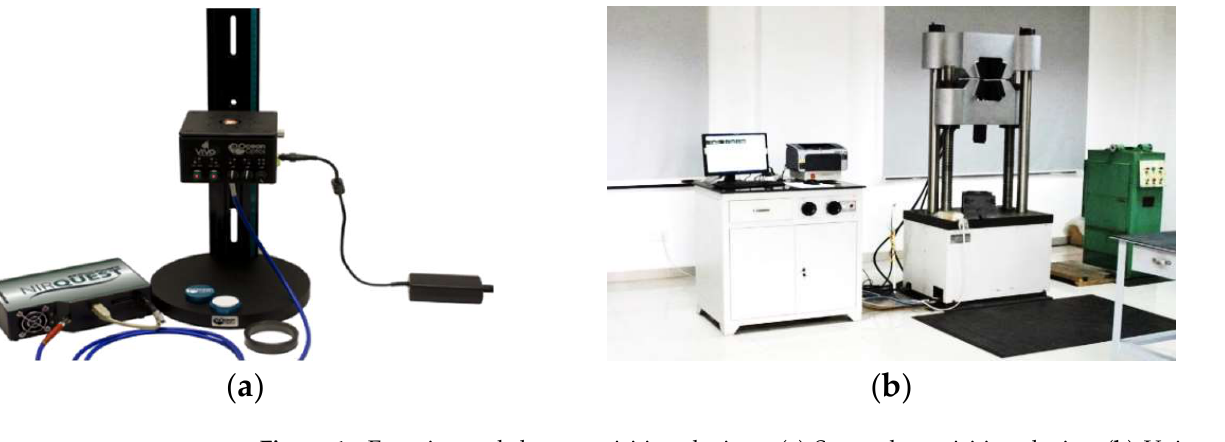
Figure 1. Experimental data acquisition devices: ( a ) Spectral acquisition device; ( b ) Universal testing machine.